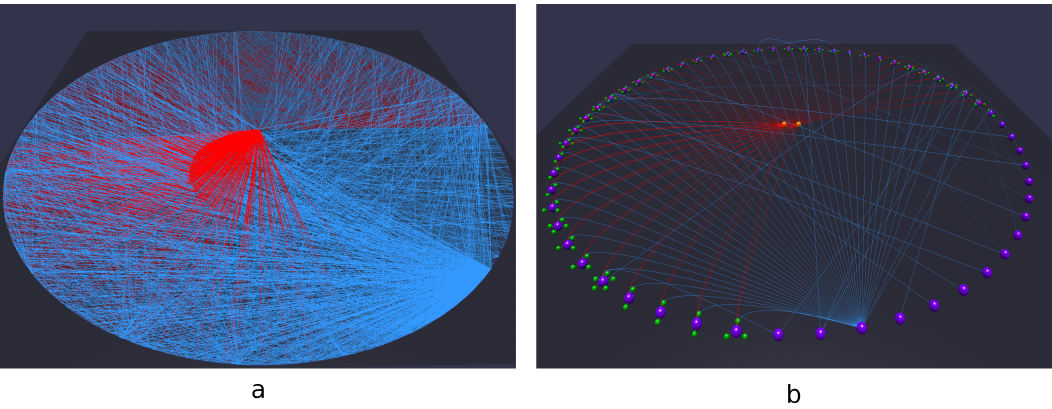
Figure 2. RDF graphs can host a number of triples too high to be effectively and efficiently visualized ( a ), but a prefiltering stage can help to visualize only a subgraph of interest ( b ). Support for RDFS and OWL : Despite being ontology agnostic (to adapt to different use cases,